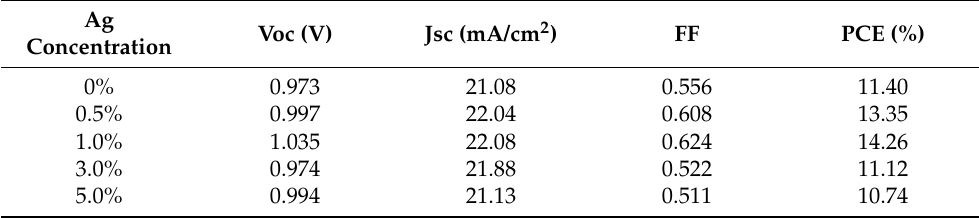
Ag and I; Figure S3. The distribution diagram of perovskite devices with Ag doping